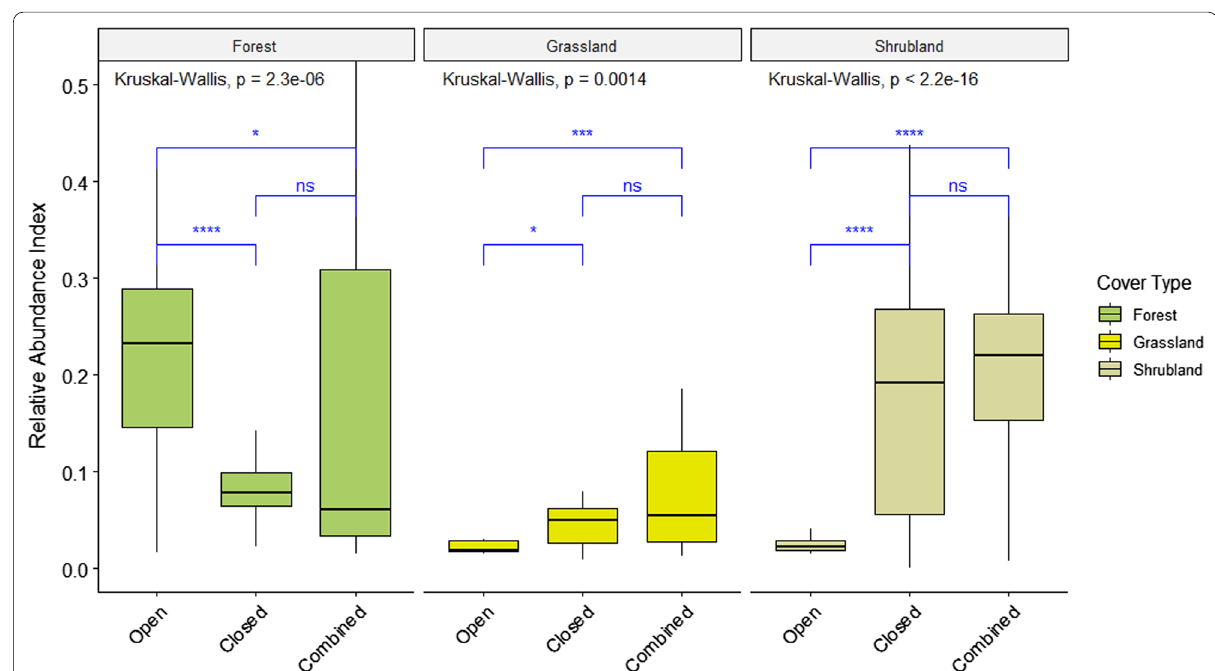
Fig. 5 Relative abundance estimates of wild pigs from model outputs (spring, fall, and combined) across landcover types only for areas with seasonal hunting (open vs. closed). Blue brackets represent the comparisons being made using the Kruskal–Wallis test. Asterisks imply significance and NS means no significant difference ( p > 0.05). Seasonal hunting areas can be seen in Fig.